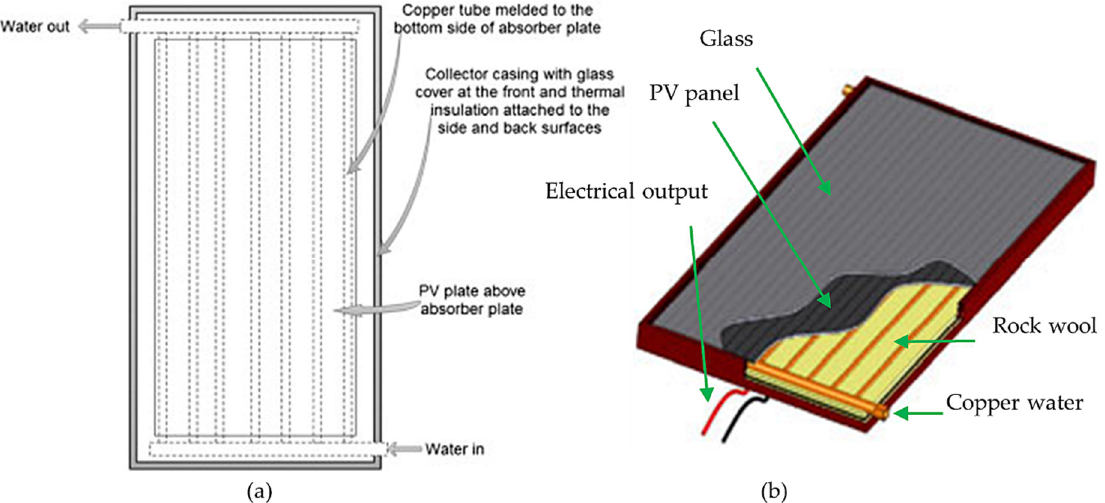
Figure 7. ST-PVT thermal collectors with harp design ( a ) Front view. Reprinted with permission from Ref. [56]. 2011. He et al. ( b ) The configuration of collector. Reprinted with permission from Ref. [50]. 2012. Akisawa et al.